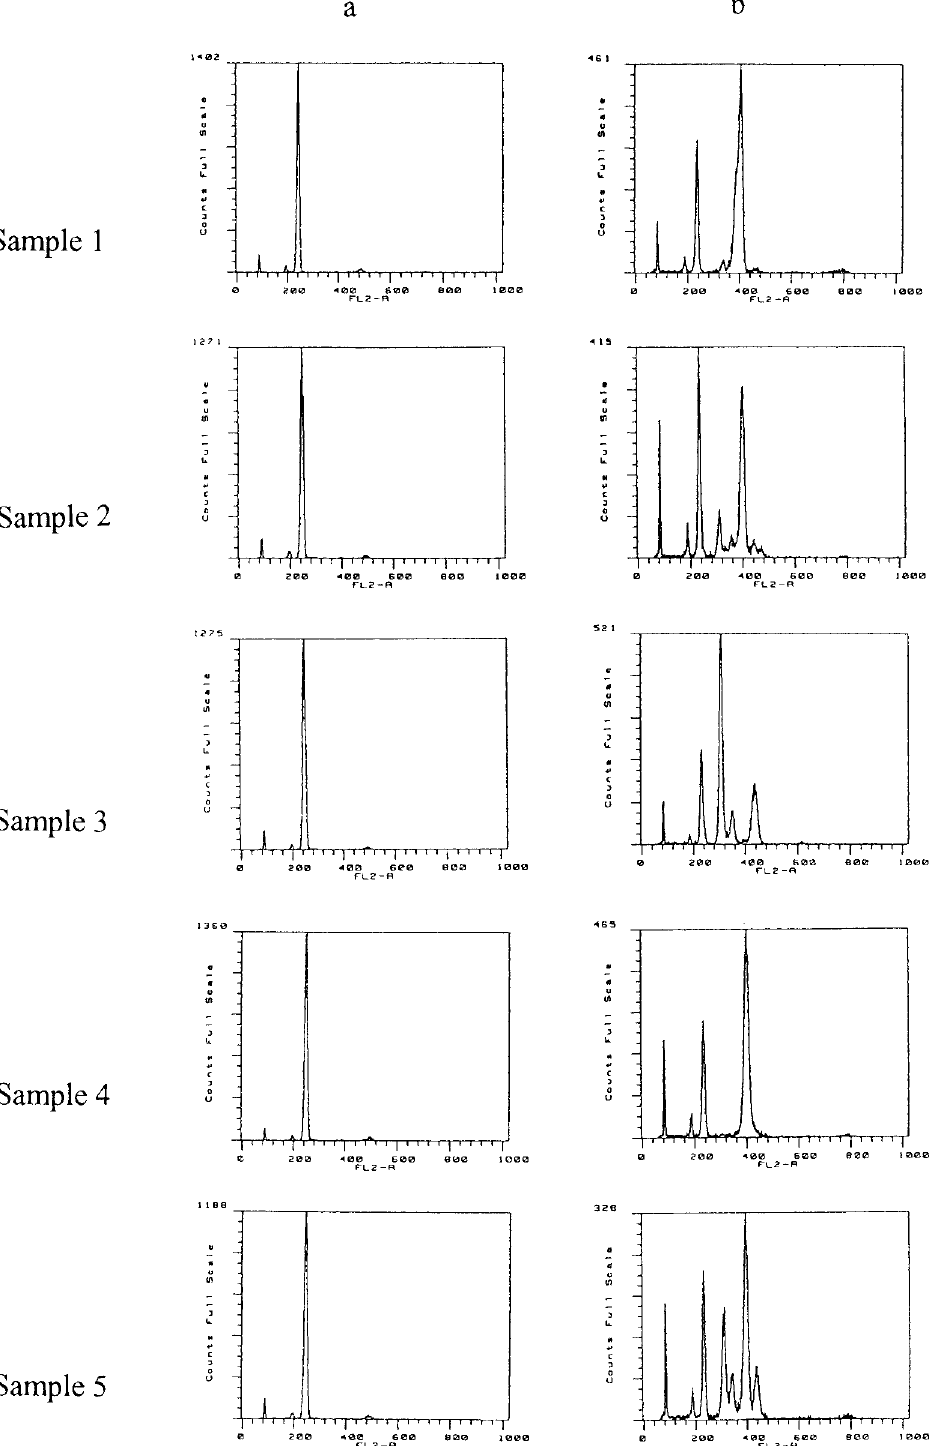
Fig. 2. FCM histograms from one homogenously euploid (a) and one multiploid (b) breast